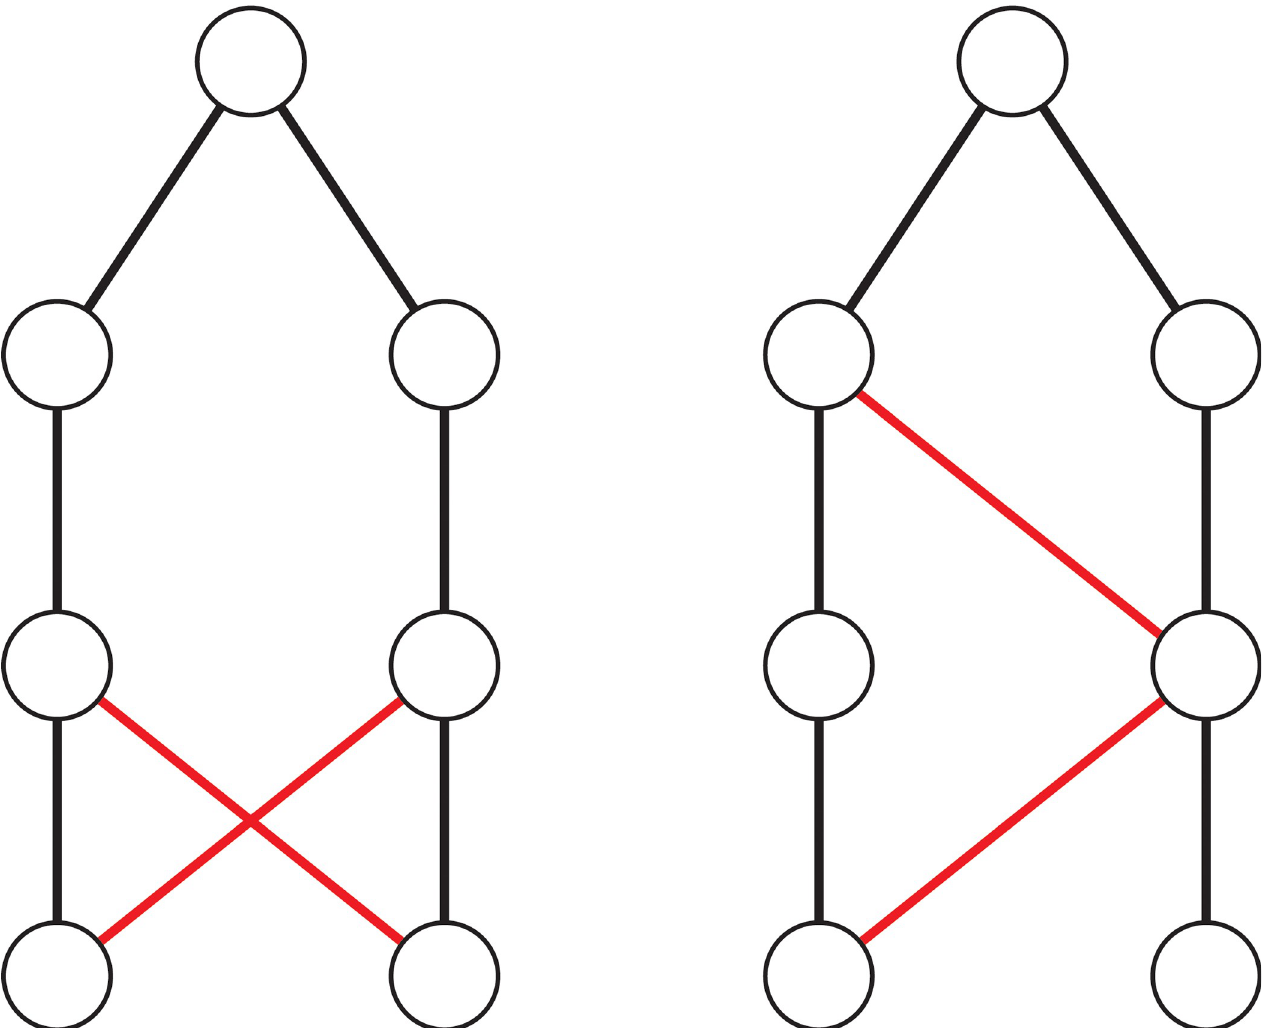
Fig 4. Supervisor / examiner relationships delayed by one generation. Black lines denote supervisor relationships. Red lines denote examiner relationships.